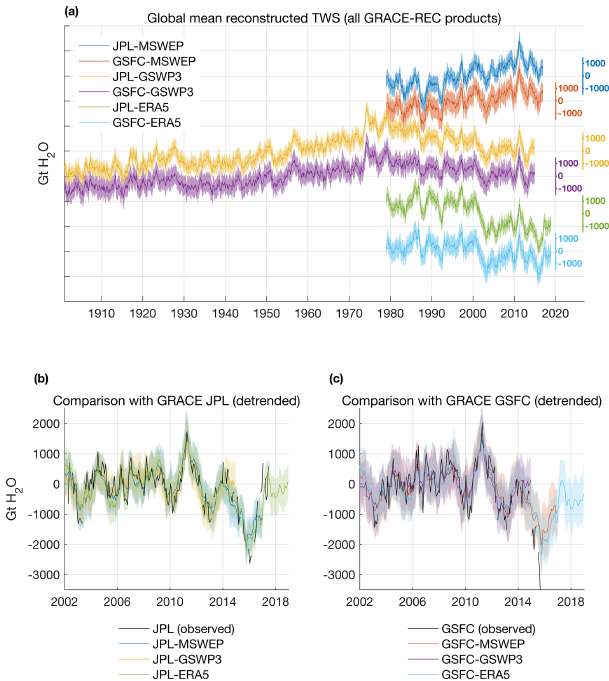
Figure 8. (a) Global average of TWS anomalies for the six GRACE-REC datasets (excluding Greenland and Antarctica) with an artificial vertical offset added for better visual comparison. (b) Comparison of the three GRACE-REC datasets calibrated with GRACE JPL against GRACE JPL (de-trended anomalies). (c) Same as (b) but for GRACE